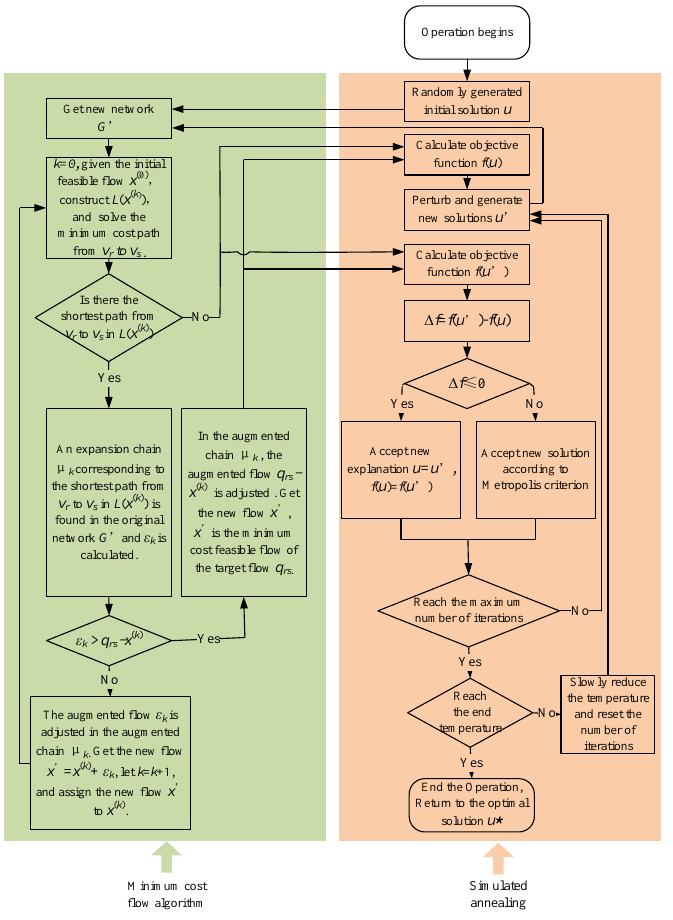
Figure 11. The flow chart of the multimodal DNDP solution algorithm.